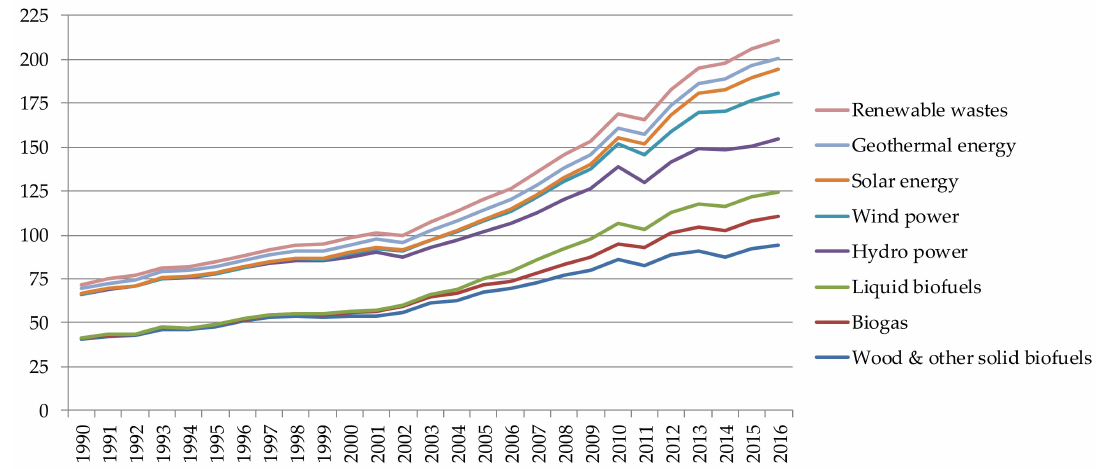
Figure 1. Primary production of energy (Mtoe) from renewable sources, EU—28, 1990–2016